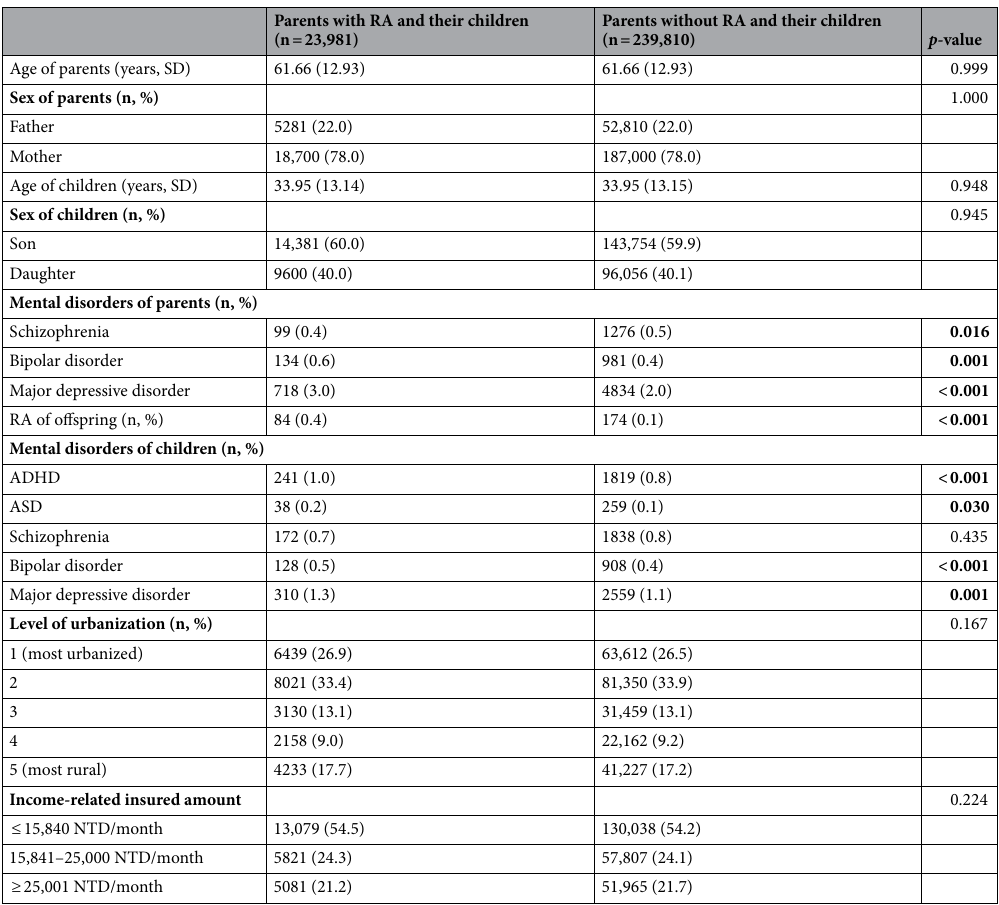
Table 1. Demographic characteristics and prevalence of mental disorders among the offspring of parents with and without rheumatoid arthritis. Note: bold figures indicate statistical significance. Abbreviations: RA rheumatoid arthritis, SD standard deviation, ADHD attention deficit hyperactivity disorder, ASD autism spectrum disorder, NTD New Taiwan